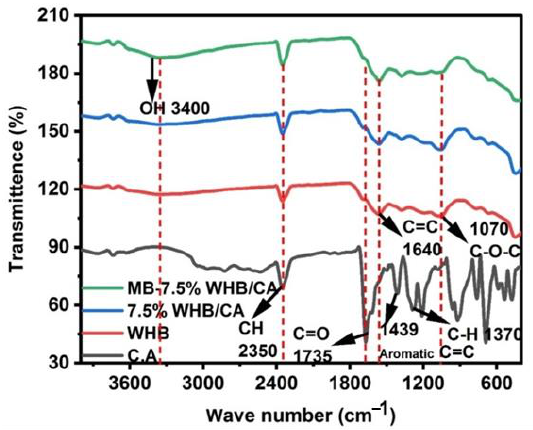
Figure 3. FTIR spectra of WHB, WHB/CA, and MB-WHB/CA.